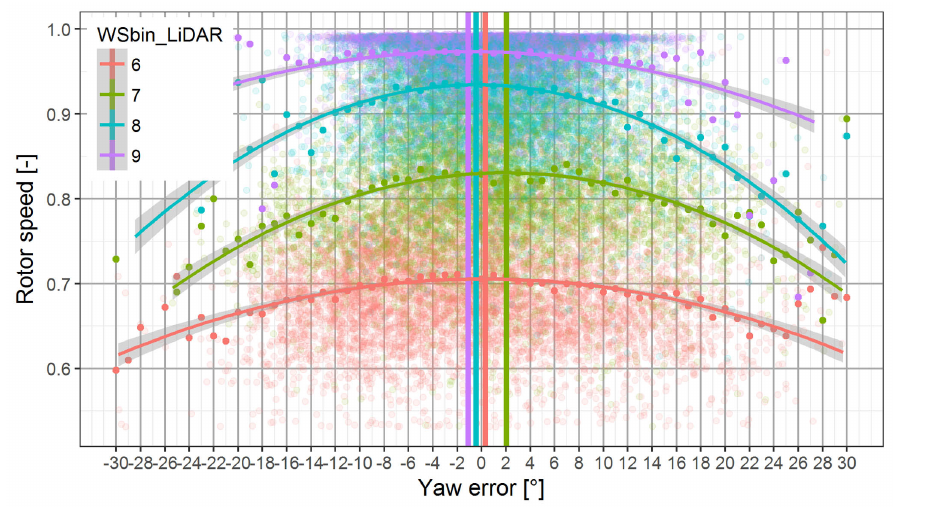
Figure 11. Determination of the optimal turbine alignment. Rotor speed grouped at different wind speed bins (WSbin) measured with a ground-based lidar plotted as a function of the yaw error. The solid points represent the average value of the respective yaw error bin. The curved lines are polynomial fits based on the method of least squares. The vertical lines are the maximum of the curve, which is the orientation of the best turbine